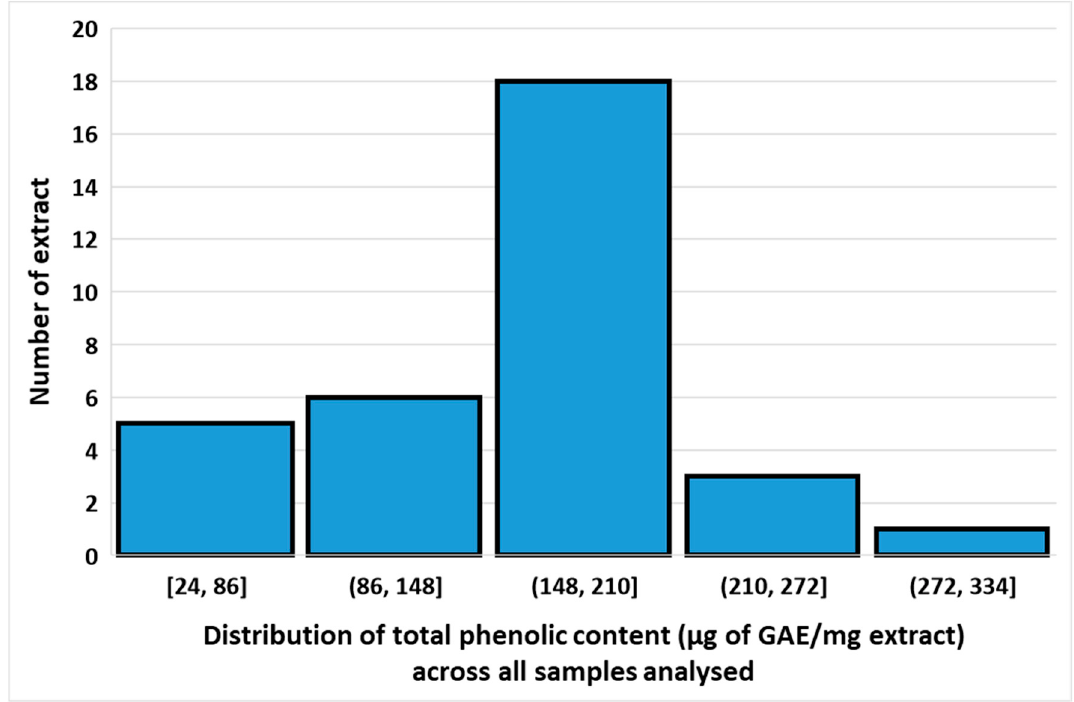
Figure 3. Distribution of total phenolic content across all samples analysed.